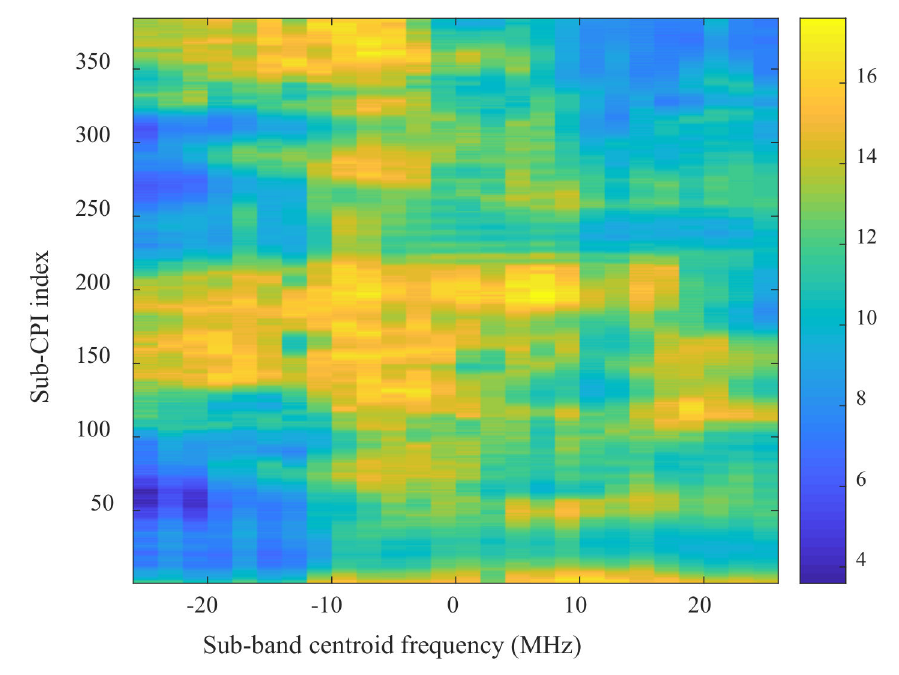
Figure 8. SCNR performance of the sub-band STAP with respect to sub-band distributions within different